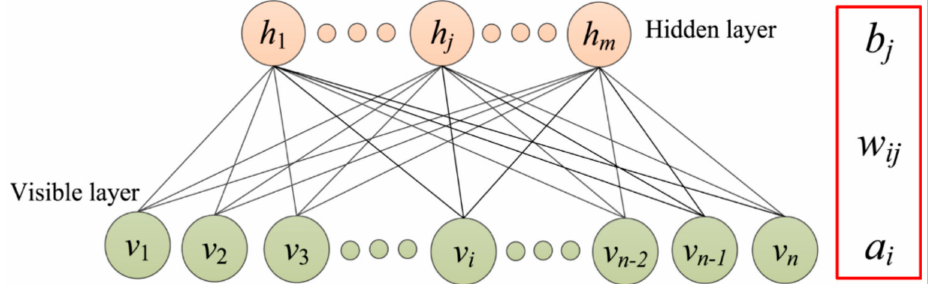
Figure 2. The configuration of the RBM for two layers. Copyright © 2021 Elsevier [29].